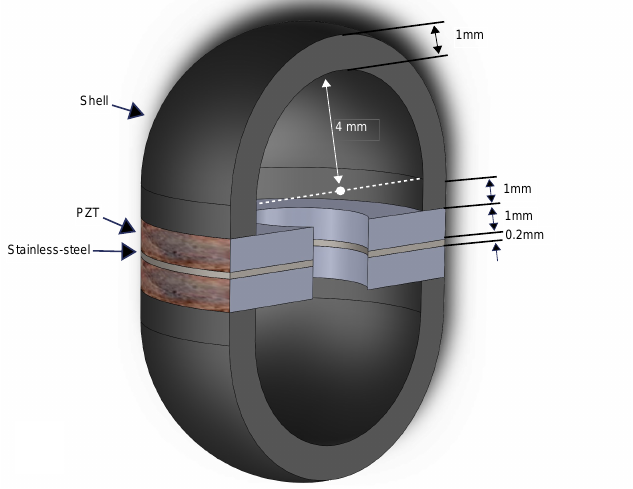
Figure 3. The final architecture and dimensions of the resonating shell transducer.